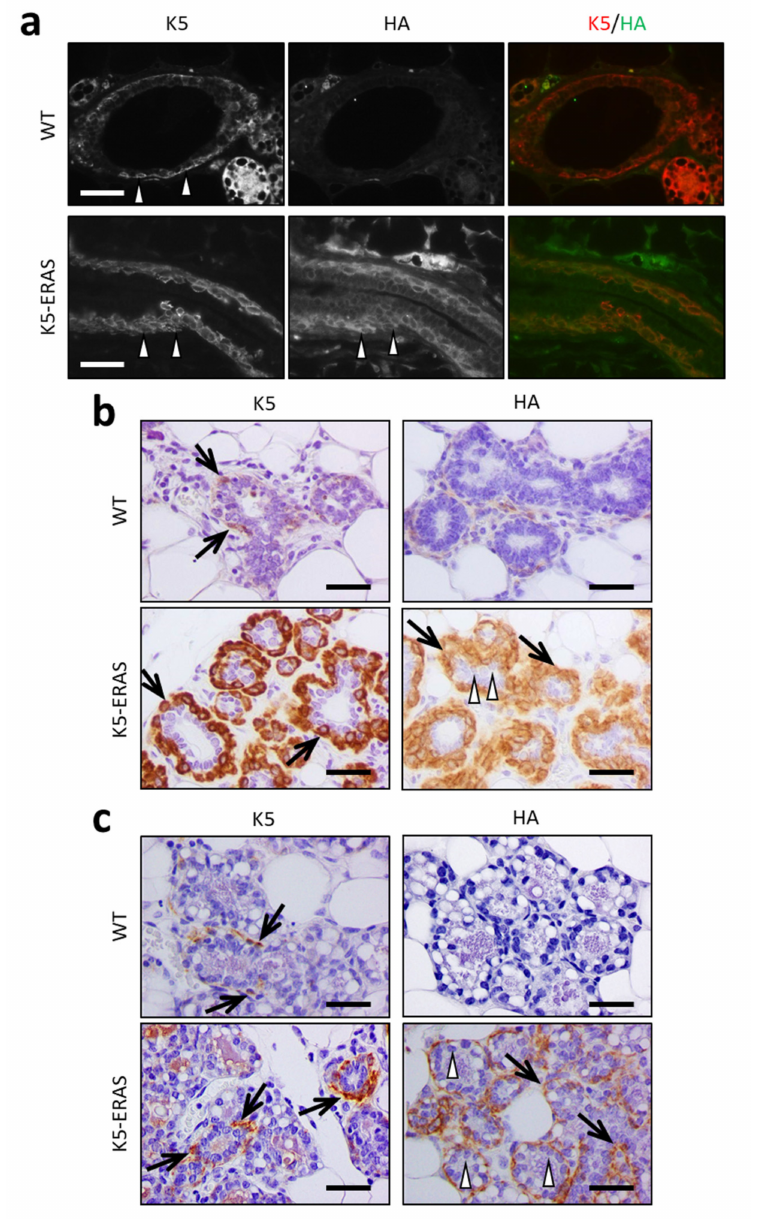
Figure 3. Mammary gland cell-type specific K5-ERAS transgene expression. ( a ) Immunofluorescence analysis of the expression of keratin K5 and the HA epitope (indicative of ERAS expression) in ducts from mammary glands of 10-week-old virgin animals. The genotype of the animals and the antibodies used are indicated. Note the lack of staining for the HA antibody in the mammary ducts of WT mice and the expression of both K5 and ERAS in most of the myoepithelial cells in the ducts of transgenic mice. The arrowheads point to representative K5-positive basal myoepithelial cells. ( b , c ) Immunohistochemical analyses of K5 and ERAS (HA epitope) expression in mammary acini of 7-month-old virgin animals ( b ) and of 17.5-day-pregnant females ( c ). The arrows point to myoepithelial cells, and the arrowheads to luminal cells. Note the co-localization of both K5 and ERAS expression in the myoepithelial cells around the acini (arrows), in contrast to the lack of expression in acinar cells (arrowheads). Myoepithelial cells in K5-ERAS females showed premalignant dysplastic changes characterized by nucleomegaly and a loss of polarity of these larger nuclei, which appeared round and perpendicular to the basal membrane of the acini in comparison to the tiny, flat nucleus disposed in parallel to the basal membrane in wild type females. Bar: 50 µ